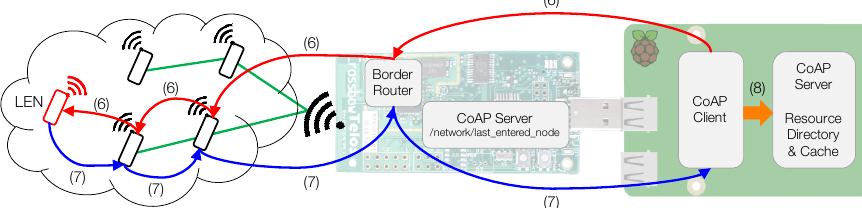
Figure 2. Resource identification procedure embedded in the RPL discovery handshake. The numbers in the figure refer to the resource identification